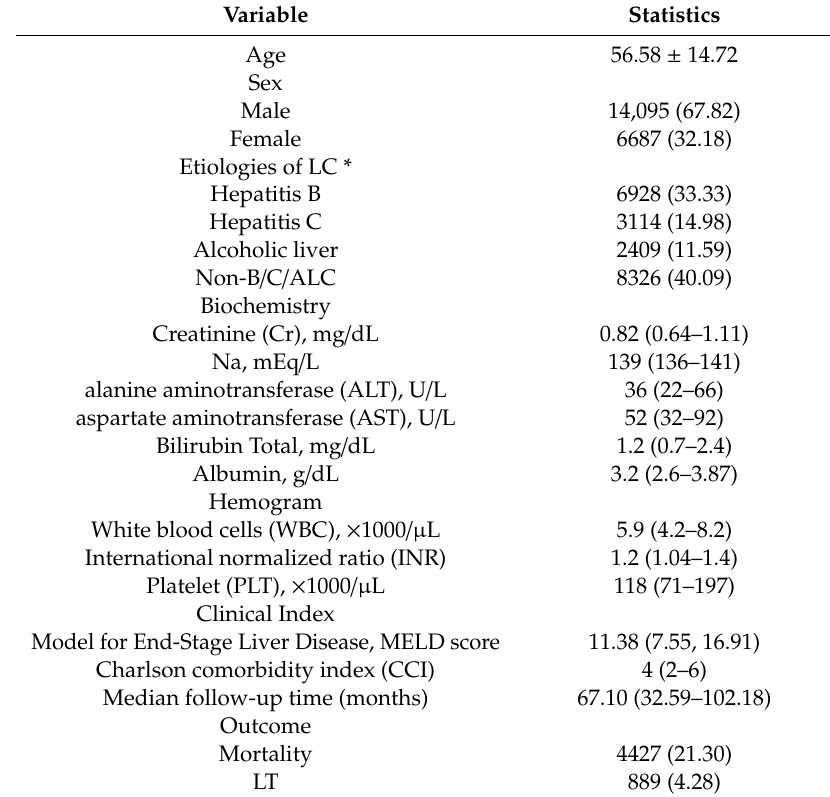
Table 2. Demographics of 20,782 cirrhotic